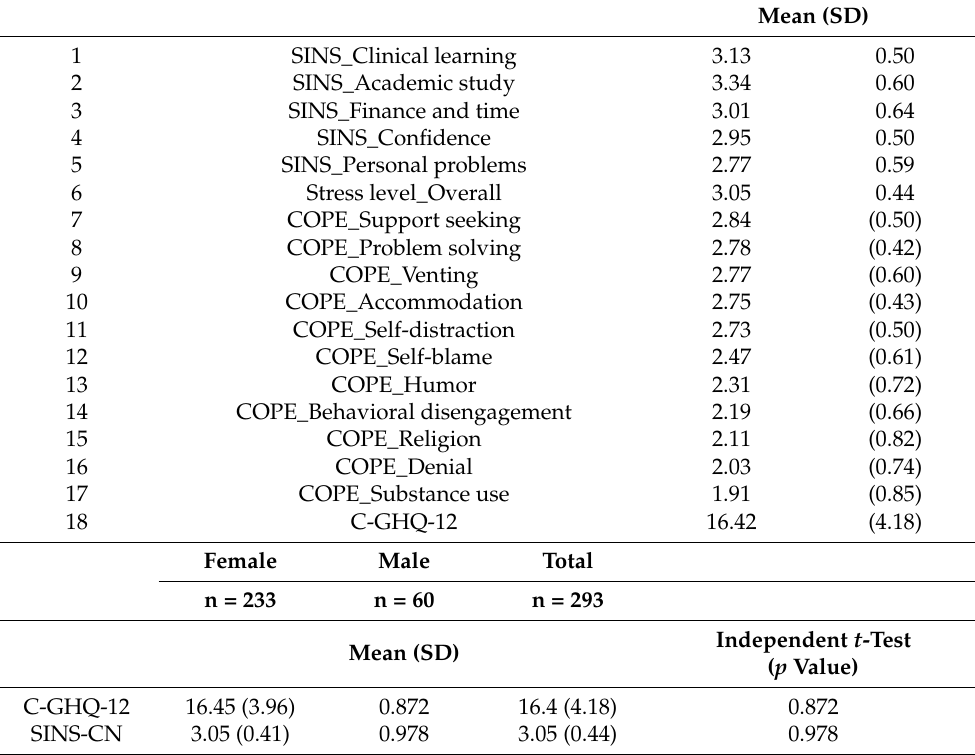
Table 1. Descriptive data of stress, coping style, and psychological well-being, and C-GHQ and C-SINS by gender (N =